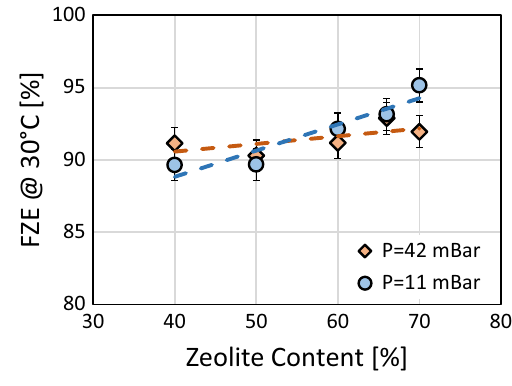
Fig. 11 Filled zeolite efficiency parameter at 30 °C vs zeolite content at P = 11 mbar and P = 42 mbar